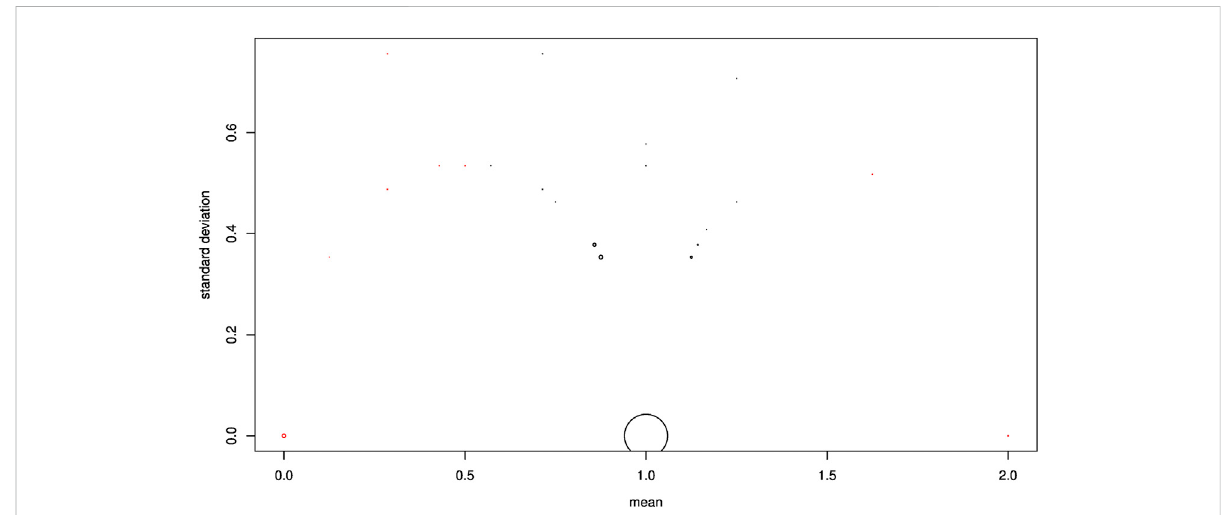
FIGURE 4 Volcanoeruptionplot.EachSNPisrepresentedbyadot.TheabscissashowsthemeangenomicscorecalculatedonF1specimens;theordinate shows the standard deviation of genomic scores calculated on F1 specimens. A coordinate point (x = 1, y = 0) is in perfect agreement with the Hardy – Weinberg equilibrium, indicating that an F1 individual is a heterozygote. Any point that deviates from (x = 1, y = 0) deviates from the HW equilibrium, indicating at least one homozygous F1 individual. All SNPs that deviate signi fi cantly from 1 on the x -axis are indicated in red; these SNPs were then discarded from the rest of the study. When several SNPs had the same coordinate, the size of the point was proportional to the number of